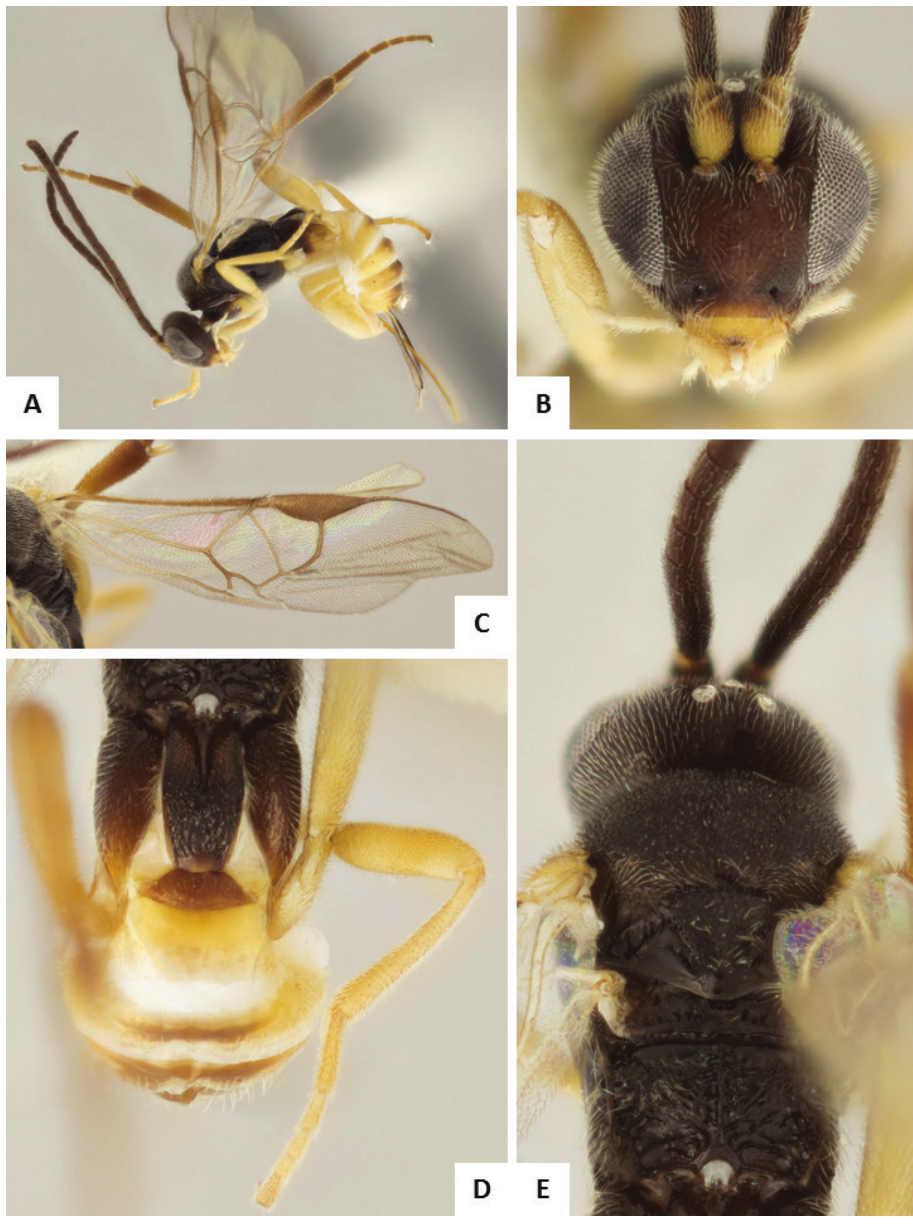
Figure 38. Pseudapanteles gouleti. A Habitus, lateral B Head, frontal C Wings D Metasoma, dorsal E Head and mesosoma,